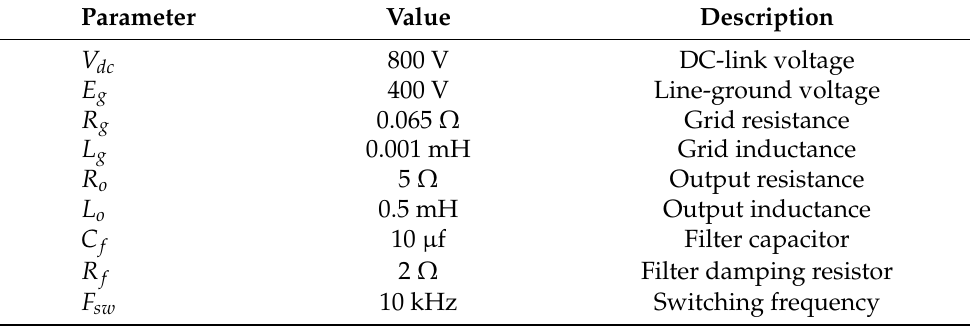
Table 1. Microgrid parameters.